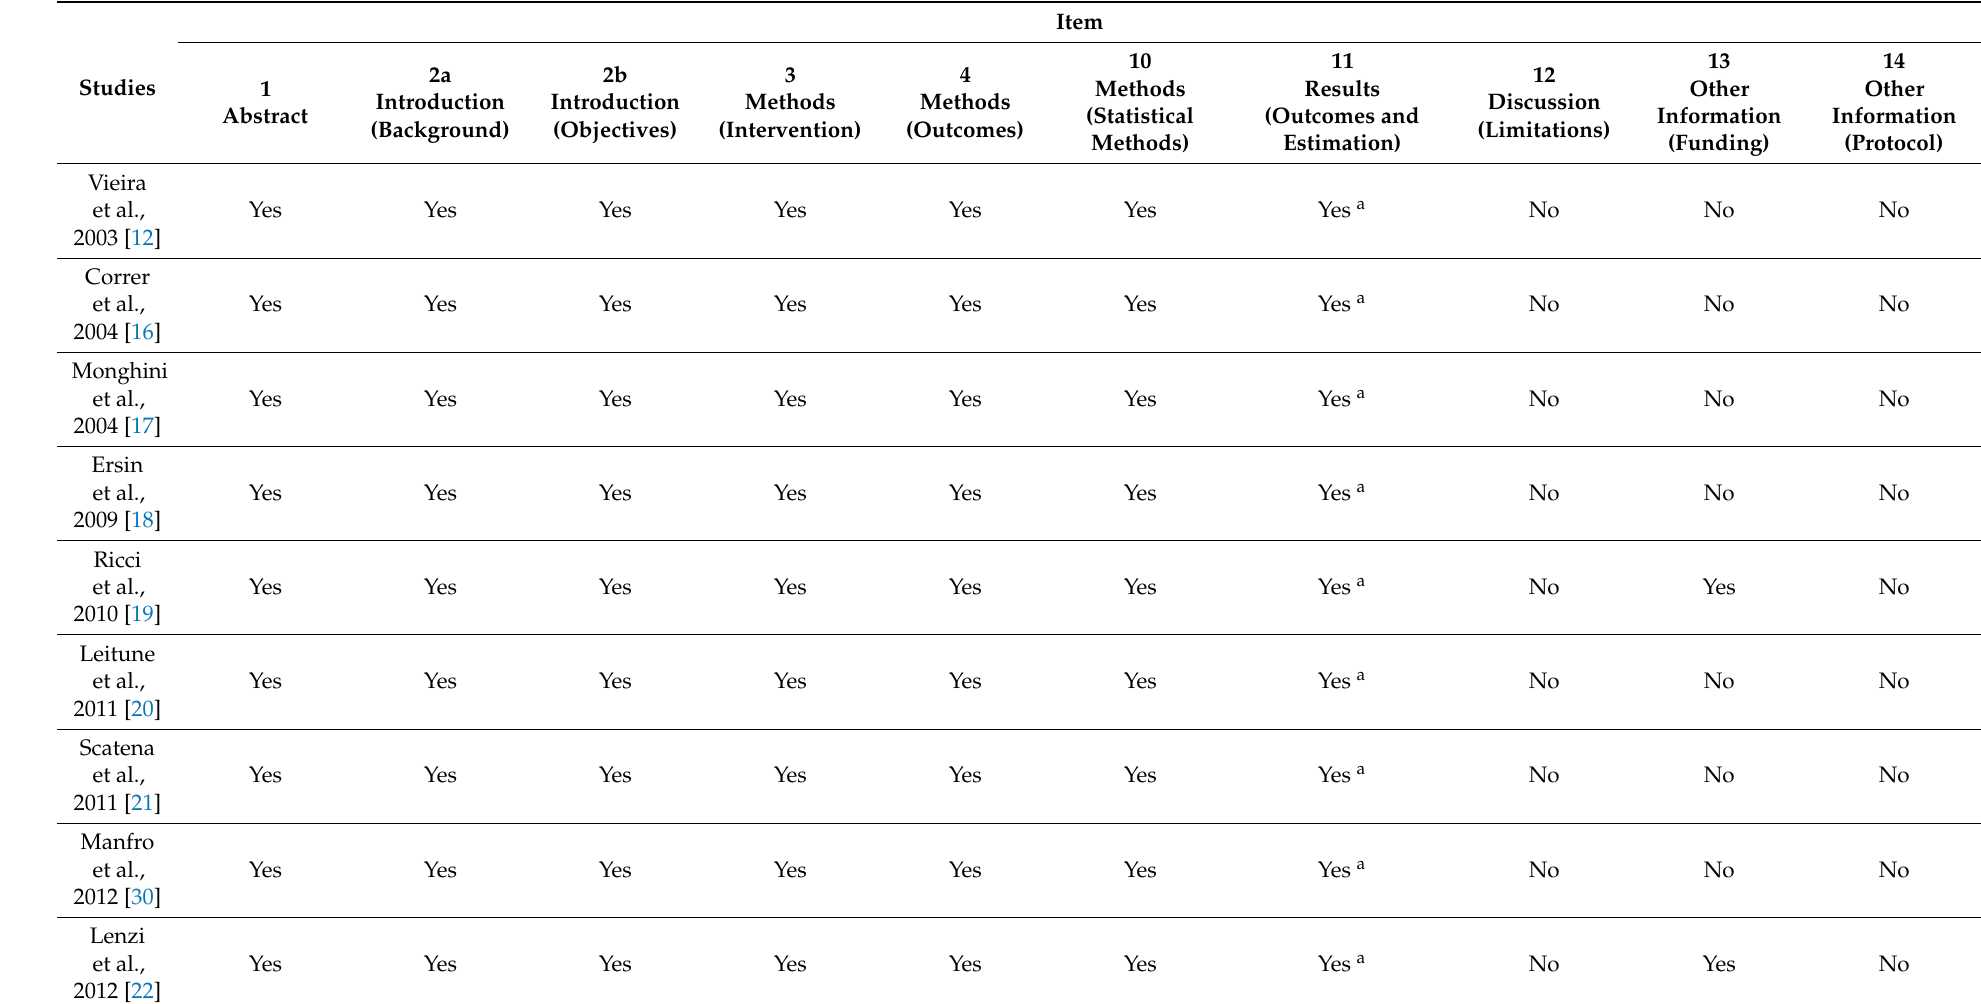
Table 2. Modified CONSORT checklist for reporting in vitro studies of dental